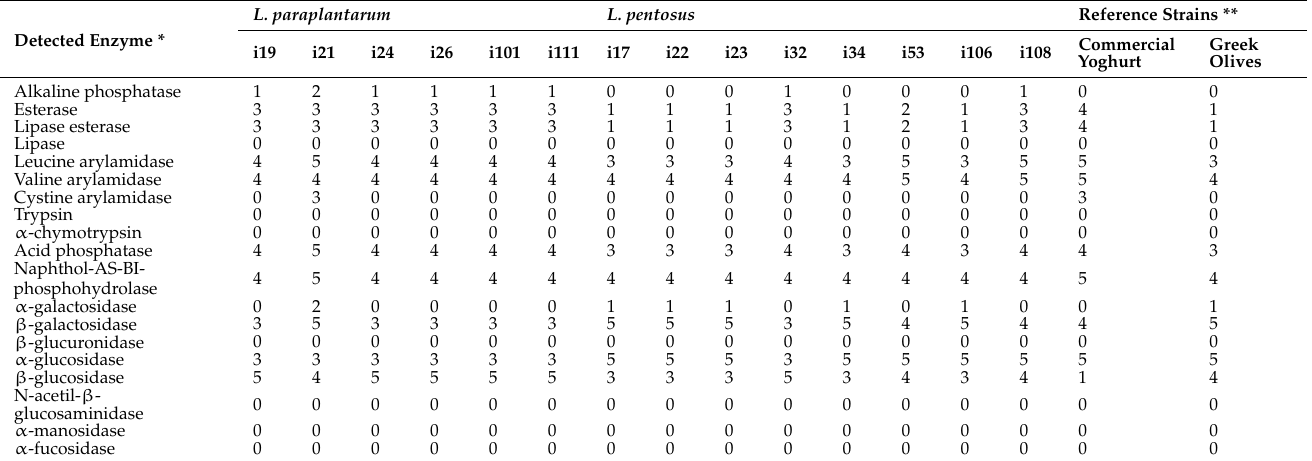
Table 6. Performance of L. pentosus and L. paraplantarum strains pertaining to enzymatic activities.